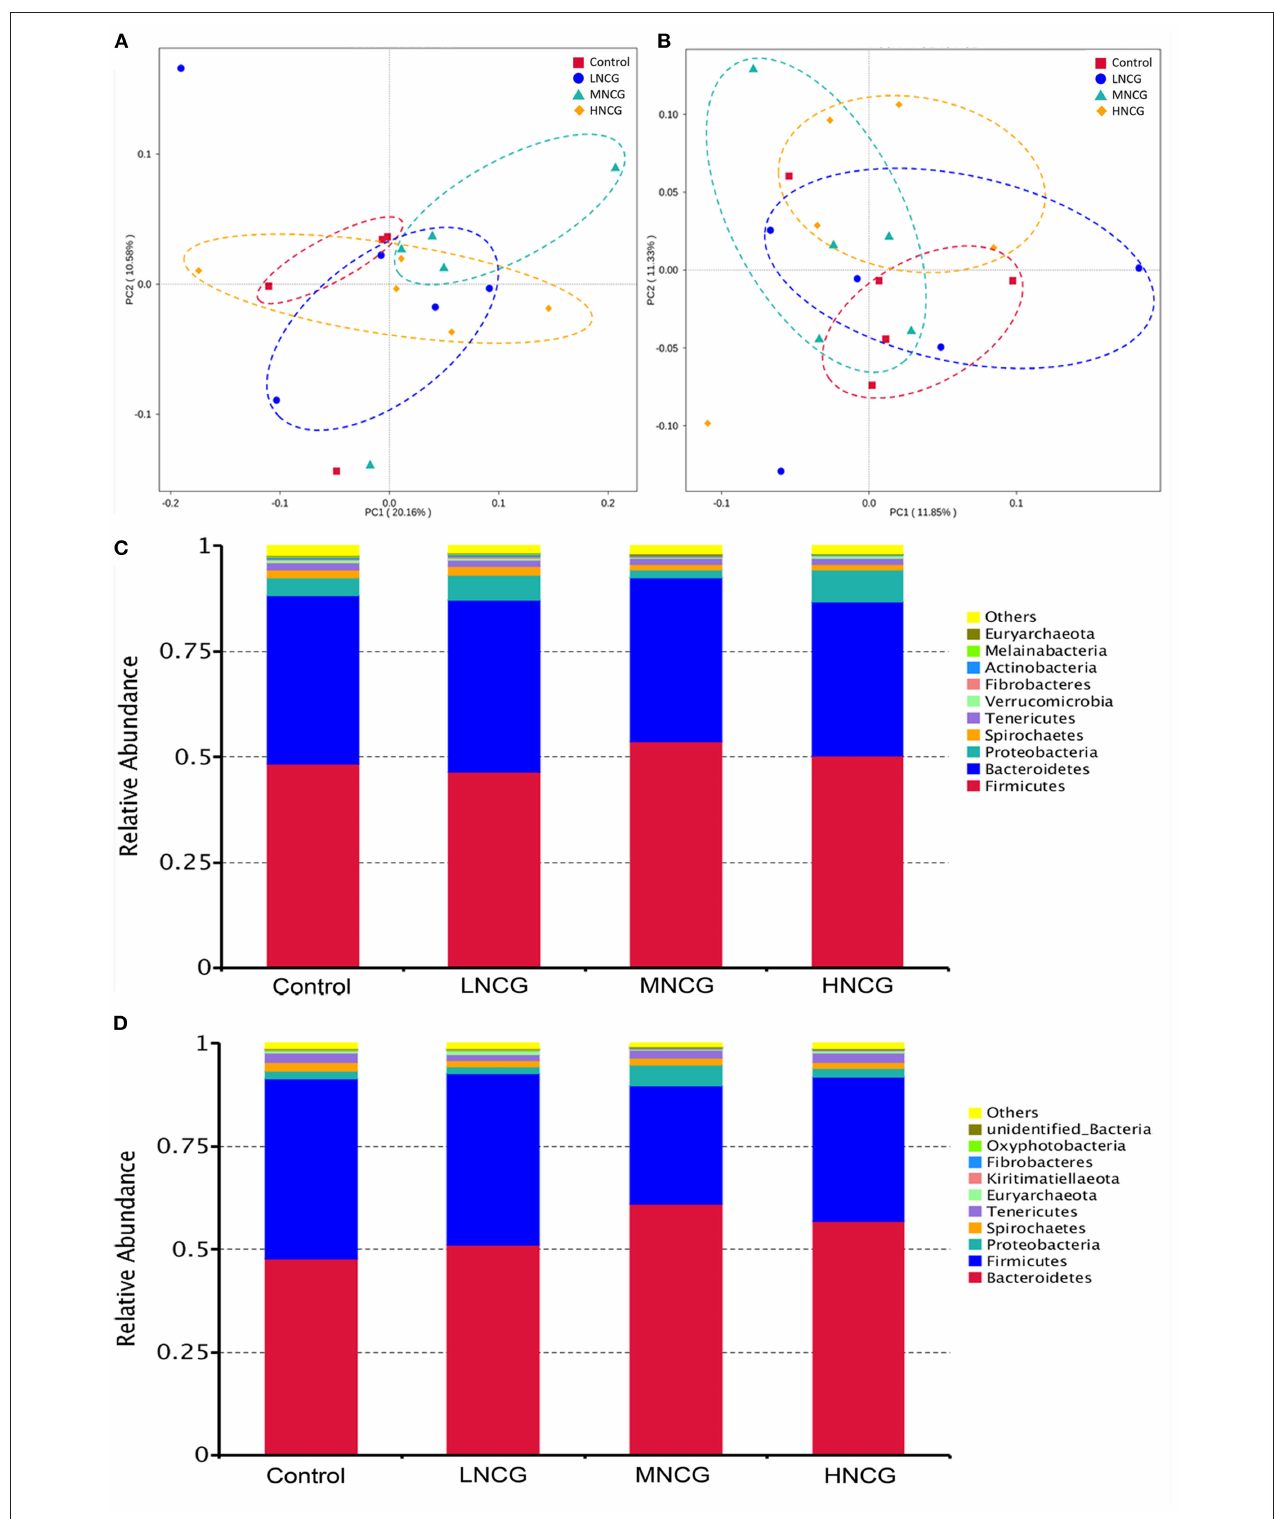
FIGURE 1 | Effects of NCG supplementation on microbiota structure and composition in ruminal content and feces. NCG, N-carbamylglutamate; Control, without NCG supplementation; LNCG, NCG at 15 g/day per cow; MNCG, NCG at 20 g/day per cow; HNCG, NCG at 25 g/day per cow. (A,B) Principal coordinate analysis (PCoA) of bacterial community structures in ruminal content (A) and feces (B) . PCoA shows the difference in the bacterial communities among control and NCG groups. (C,D) The composition of the ruminal (C) and fecal (D) microbial community at the phylum level.